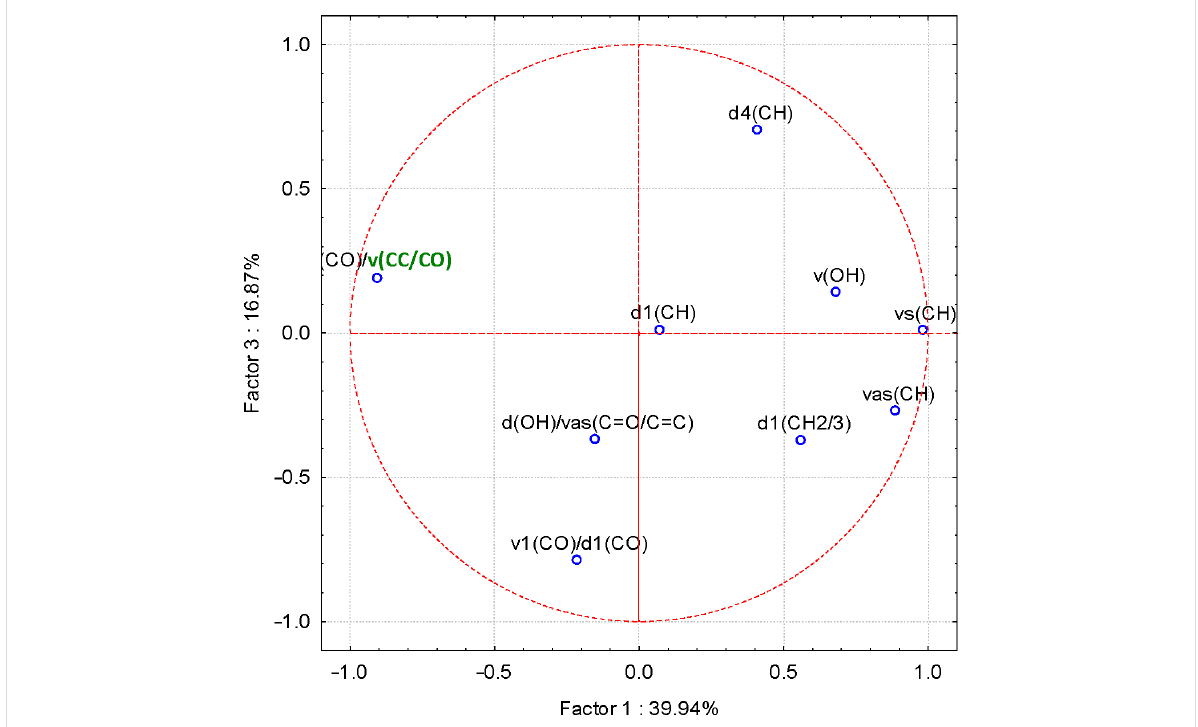
Figure 11: PC 3 versus PC 1 loadings plot from the FTIR–PCA analysis of the β -CD/hazelnut oil/flavonoid ternary complexes and flavonoids; only wavenumbers of the FTIR bands were used as input variables (see Table S12 in Supporting Information File 1 for codes).